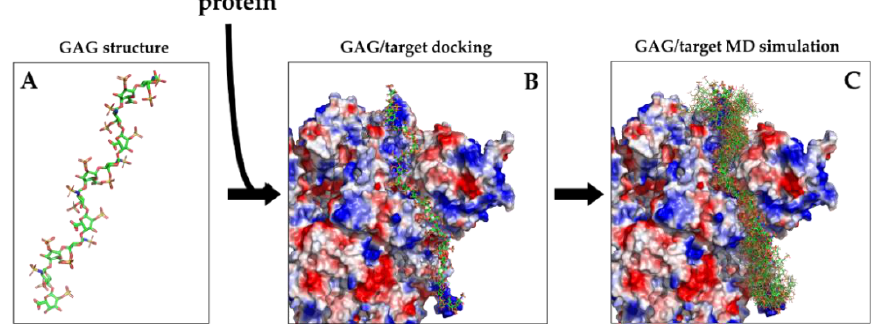
Figure 7. ( A ) Crystal structure of a 12-mers heparin (PDBid 1HPN) shown in stick representation colored by elements with green carbons. ( B ) Structure of a 31-mers heparin obtained with the incremental docking method [44] and docked to the spike protein of SARS-CoV2 virus shown as electrostatic potential surface to highlight the basic path to which heparin binds. ( C ) Superimposition of 20 snapshots from 1 µ s of MD simulation of the 31-mers heparin/spike complex showing the cloud of conformations adopted by heparin on the protein surface (adapted from Paiardi et al. https://arxiv.org/abs/2103.07722, accessed on April 12, 2021).